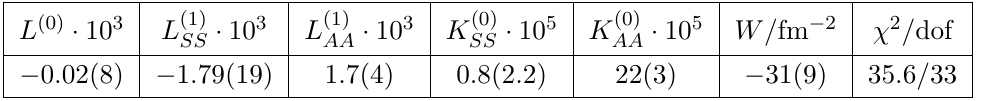
Table 7 . Results of fits to the energy shift in both SS and AA channels to SU(4) and U(4) ChPT, as indicated in the first column.